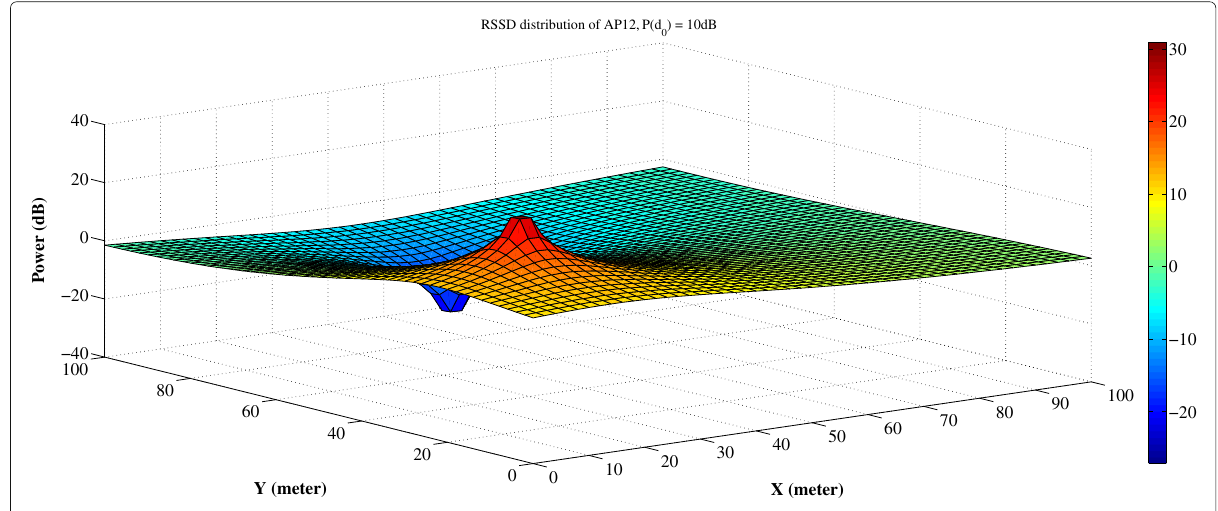
Fig. 10 RSSD distribution of AP12. P ( d 0 ) = 10 dB, α = 1.8, d = 2 m, and σ = 5.2